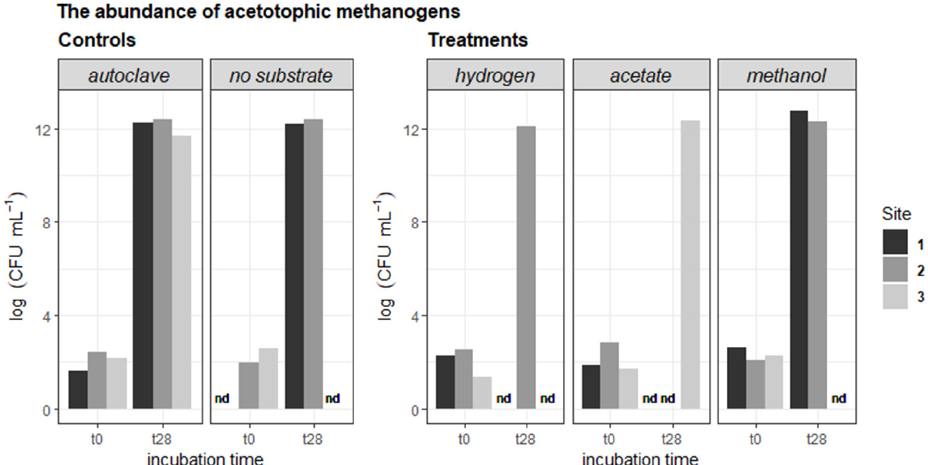
Figure 6. The abundance of acetotrophic methanogens in the sediment slurries on Days 0 (t0) and 28 (t28), counted on the selective agar media. Treatment indicated at the top of each panel. The values are the average of two replicates and five depths. “nd” means “not detected” .